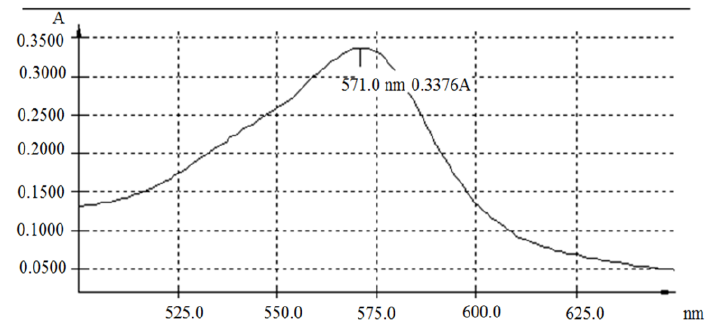
Fig. 10. Fructose spectrum with α-naphthol and additives (urea 3 mg/ml and boric acid 6 mg/ml) in the inulin complex after hydroly- sis for 15 minutes